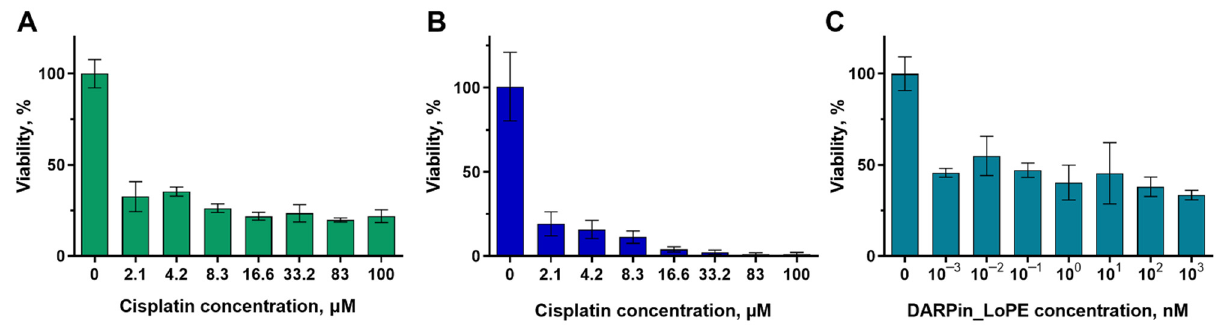
Figure 3. The dependence of the viability of monolayer cultures on the concentration of antitumor agent 72 h after the start of exposure. ( A , B ) Cisplatin toxicity against the SKOV3.ip-kat ( A ) and A431-GFP ( B ) cell lines. ( C ) Activity of recombinant targeted toxin DARPin-LoPE against the SKOV3.ip-kat cell line. The data are presented as mean ± standard deviation.